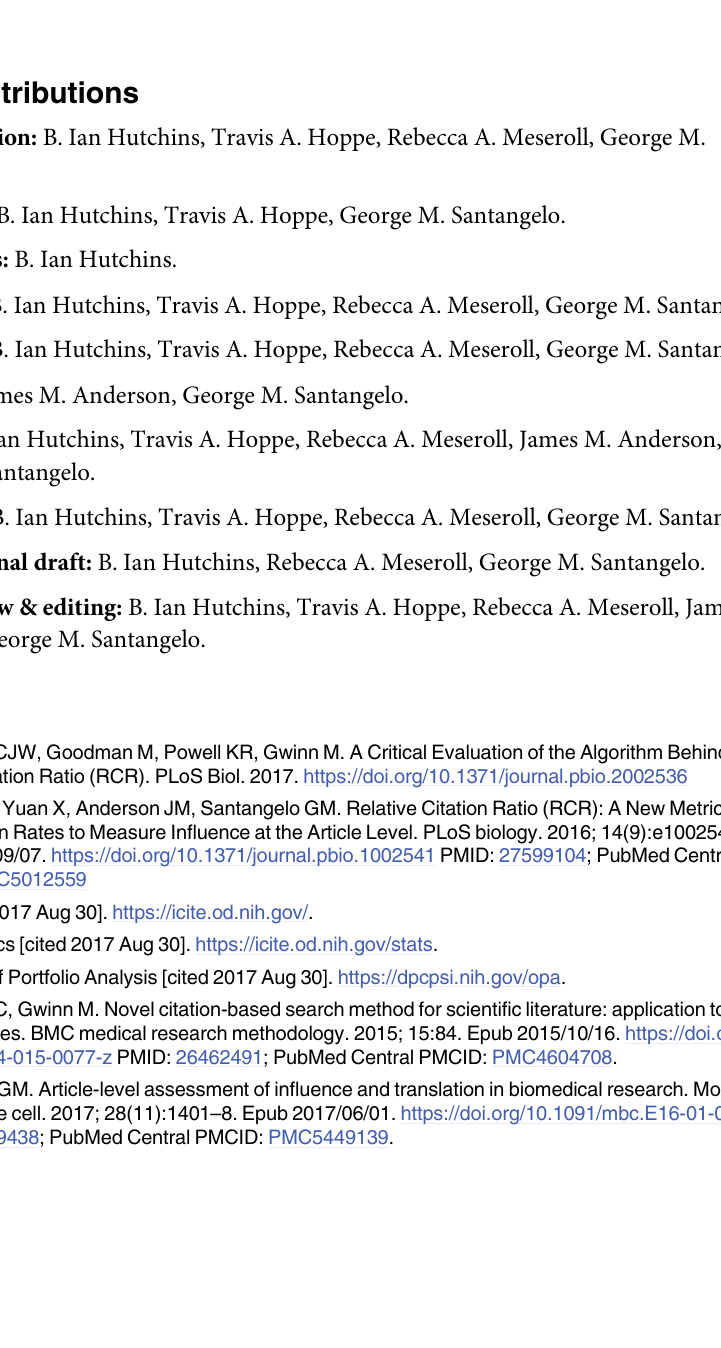
S1 Data. Data underlying the Fig 1